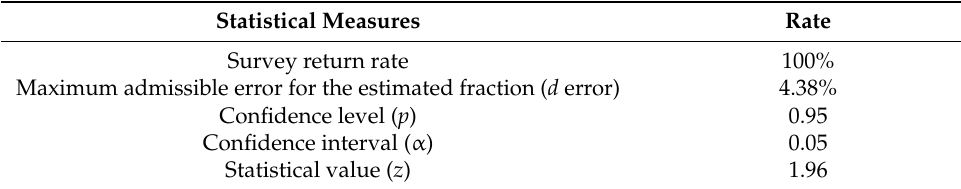
Table 2. Primary statistical